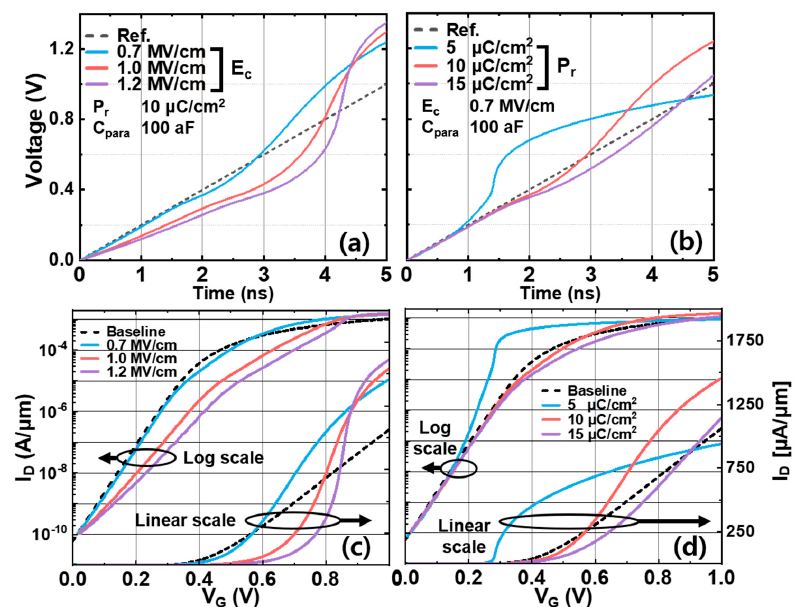
Figure 4. V INT -vs.-time for a few E c ( a ) and P r ( b ). The black-colored dotted reference line indicates the 100 MHz 1 V triangular pulse. The estimated drain current-vs.-gate voltage (I D -vs.-V G ) of baseline FinFET (see the black-colored solid line) and MFMIS NC FinFET (see the blue/red/purple-colored solid lines) for a few E c ( c ) and P r ( d ).